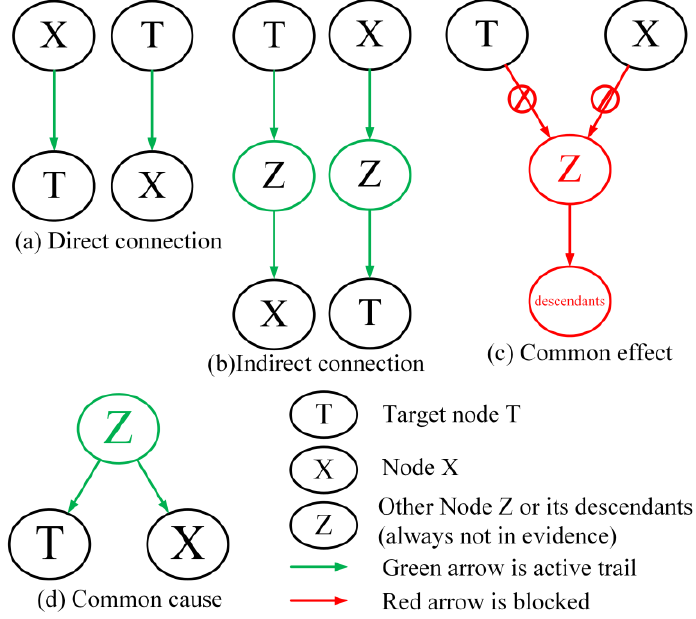
Figure 2. The relationships between target node T and other nodes.